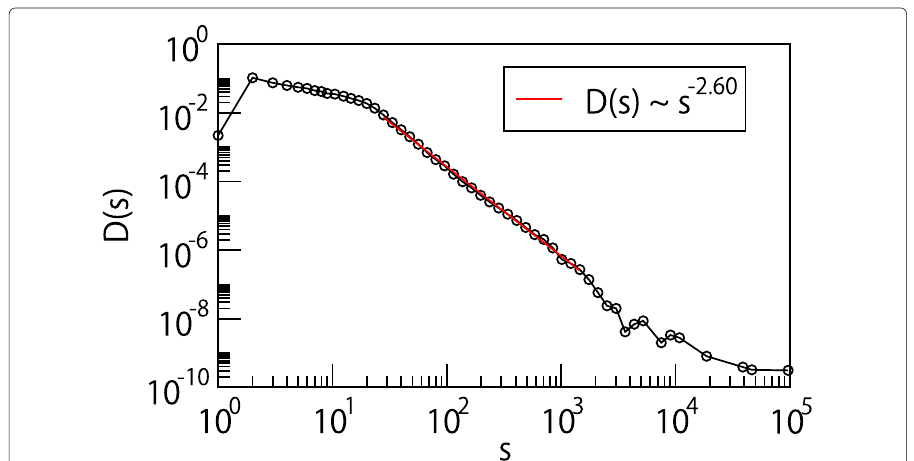
Fig. 7 The probability density distributions D ( s ) of community sizes s for the GON. The red line indicates the